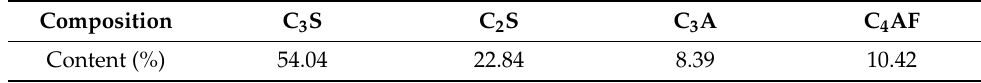
Table 2. Mineral composition of the P · O 42.5 cement.